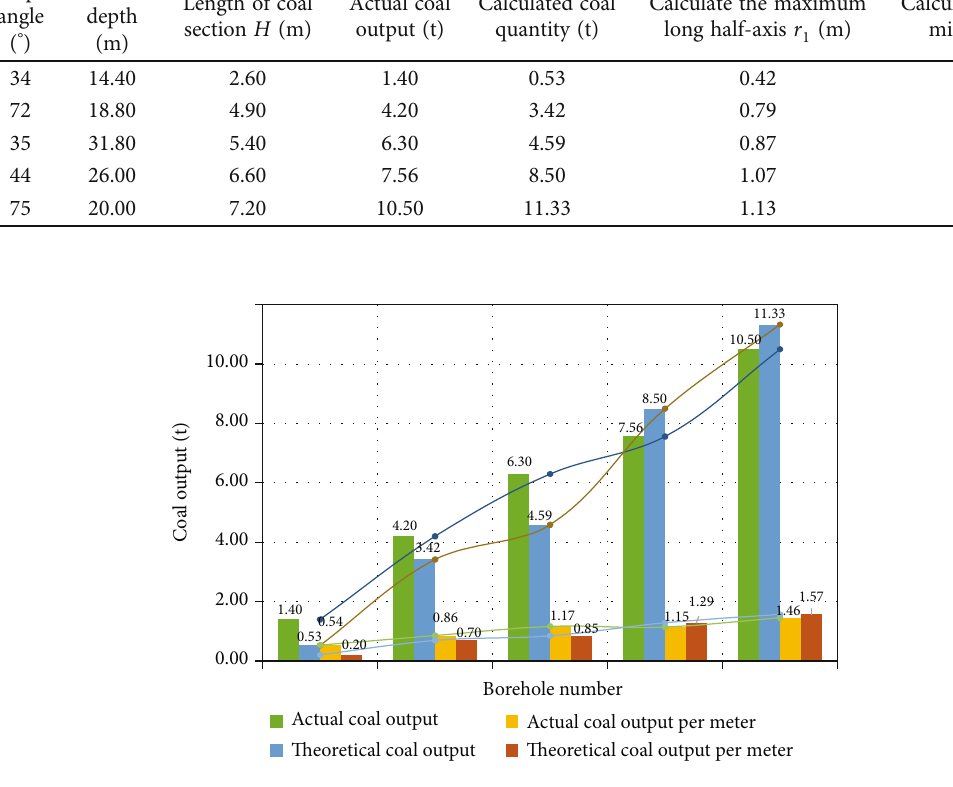
Figure 10: Comparison between the actual coal output and the calculated coal